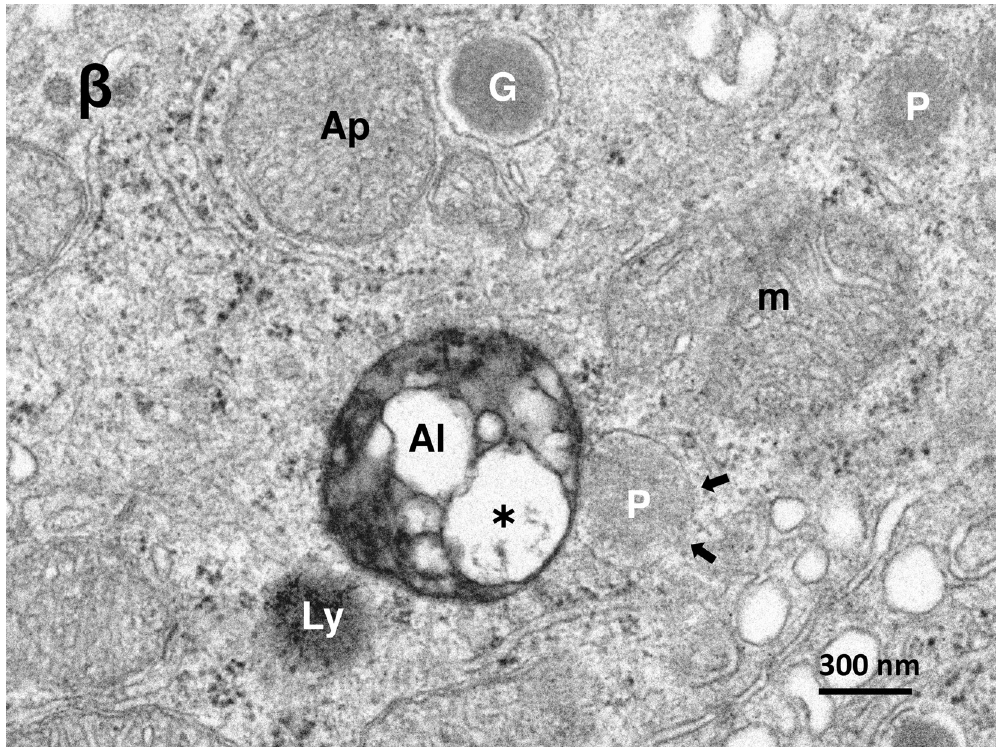
Fig 4. Electron micrograph of the β -cell in the monkey after the hydroxynonenal injections. β -cell shows fusion of an autolysosome (Al) with a peroxisome (P) exhibiting membrane disruption (arrows). The autolysosome (Al) contains mitochondria-derived debris (asterisk). The neighbouring lysosome (Ly) shows membrane permeabilization. G: insulin granule, Ap: autophagosome, m: degenerating mitochondria.